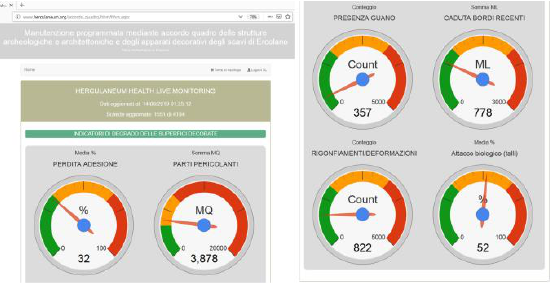
Figure 6: Gauge charts (created with Google Charts - https://developers.google.com/chart/interactive/docs/gallery/g auge) used to visualize dynamic data to monitor the state of decay of the